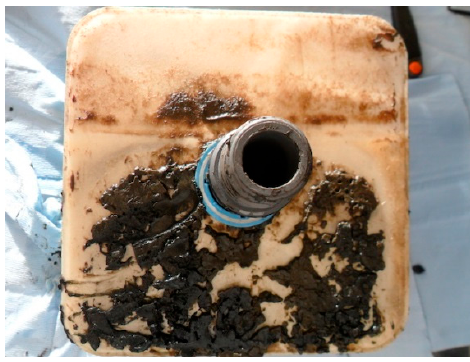
Figure 14. Impact of fouling on the square-shaped MBR system—uneven caking is observed.